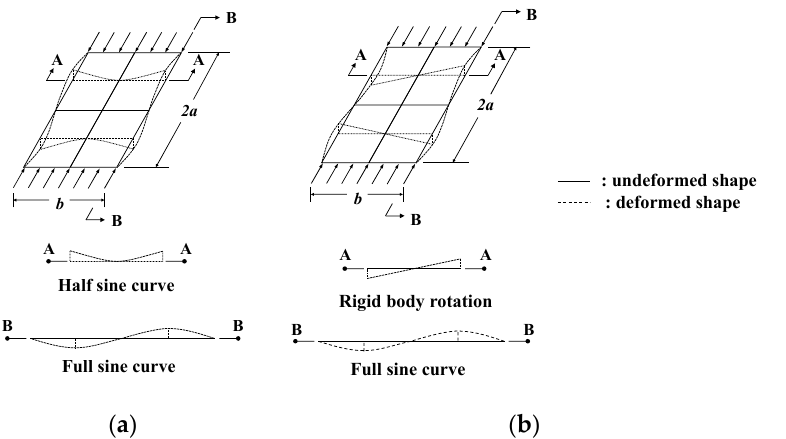
Figure 19. Comparison of buckling mode shapes between ( a ) fixed support condition, and ( b ) hinge support condition.